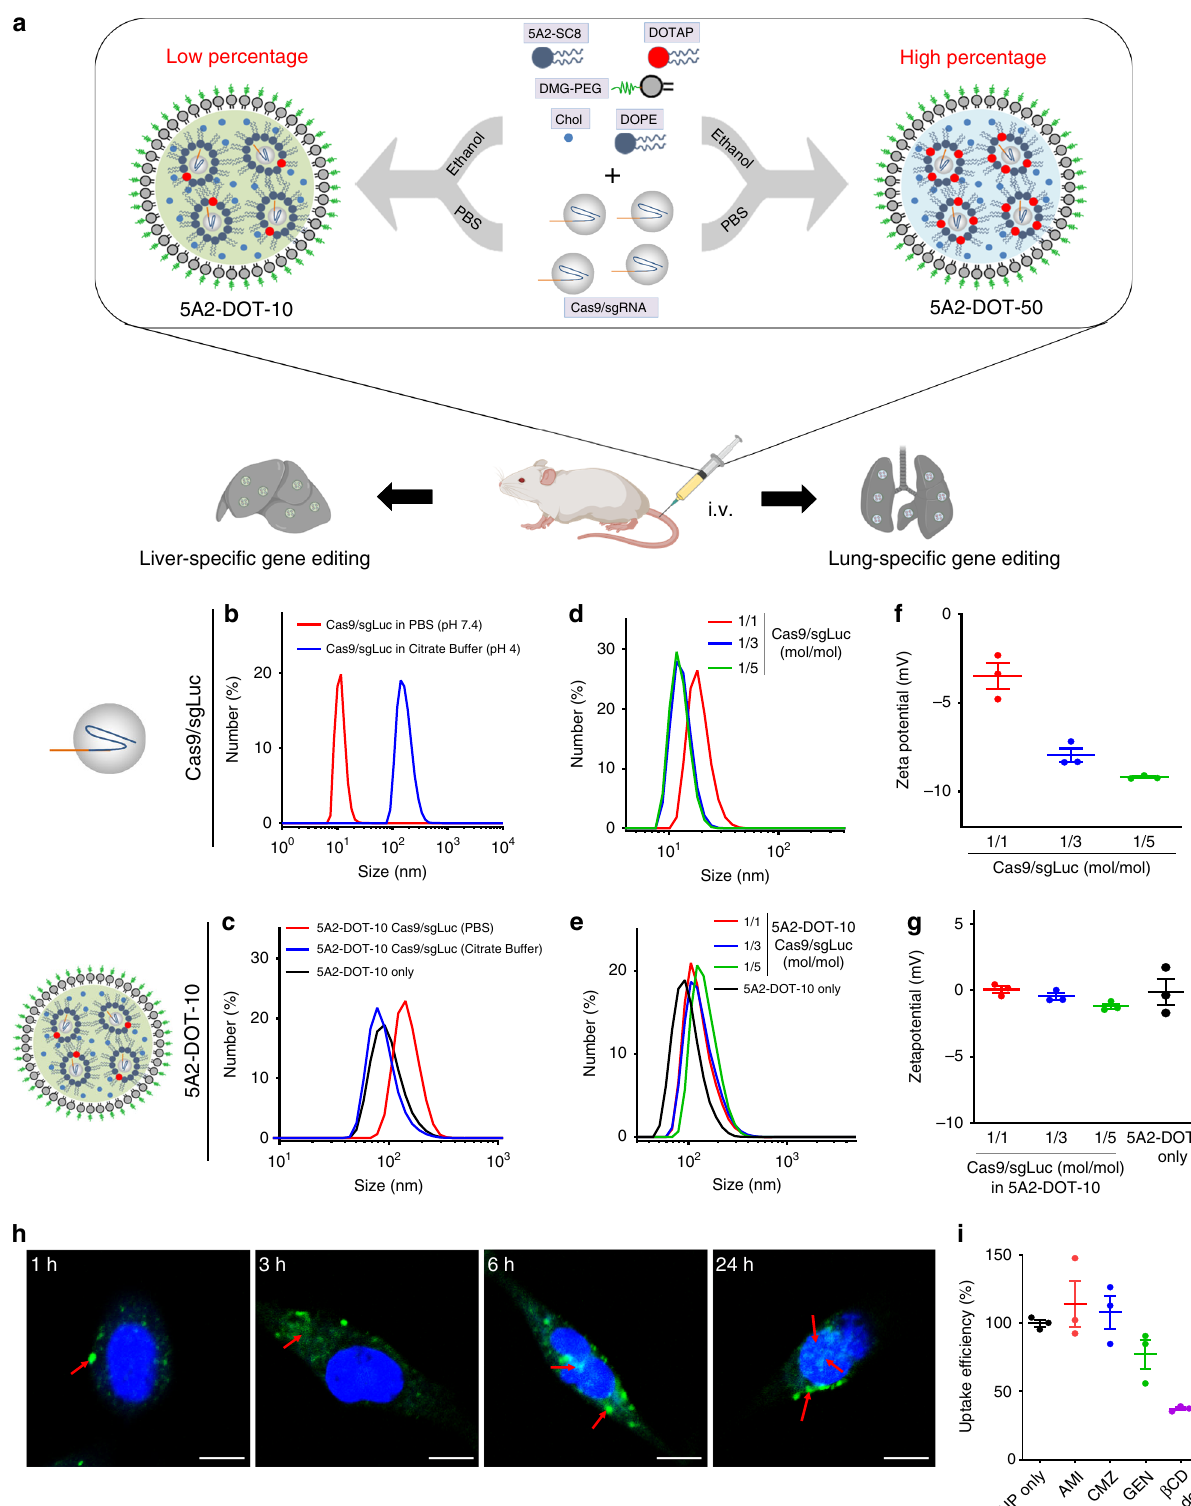
evaluated the gene editing ef fi ciency of 5A2-DOT-10 prepared using pH 4 citrate buffer. No cleavage bands were observed (Fig. 2a) by T7EI. This result was further con fi rmed by Sanger sequencing, providing additional evidence that the conventional acid-based formulation methods could not produce ef fi